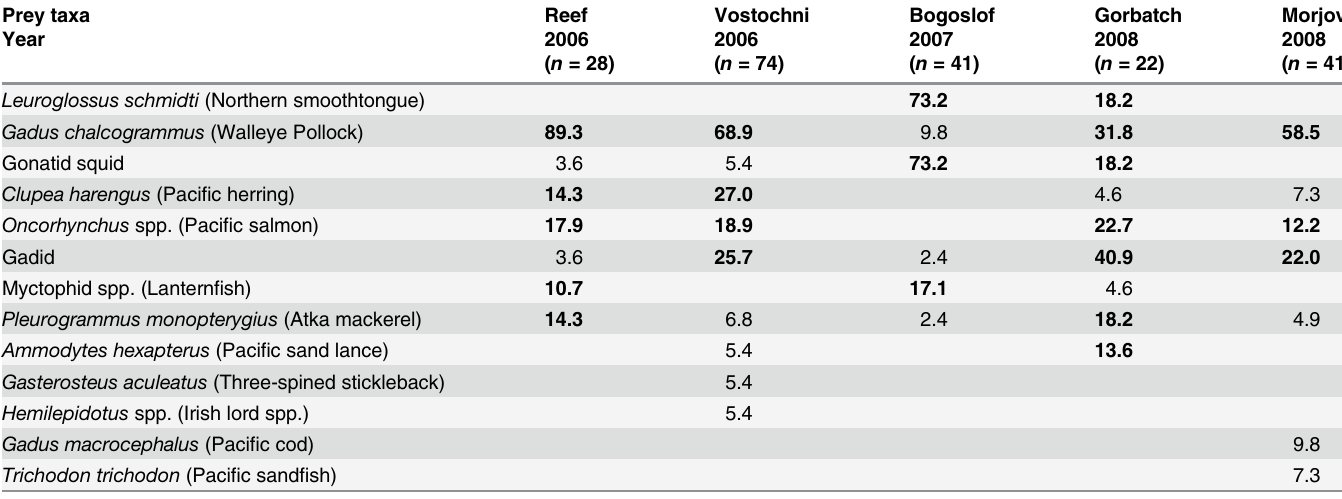
Table 3. Percent frequency of occurrence (%FO > 5.0%) of prey taxa retrieved from northern fur seal fecal samples collected at rookeries from 2006 –